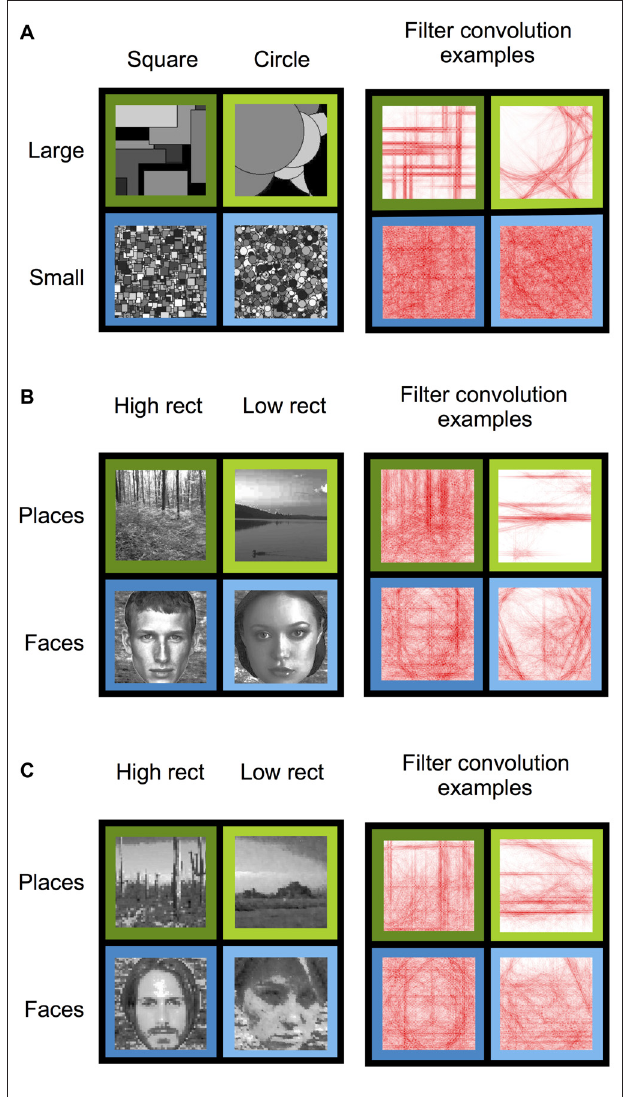
FIGURE 1 | Stimulus conditions (left) and example right angle convolution intensities (right) for Experiments 1–3. (A) Experiment 1 stimuli consisted of squares (high-rectilinearity) and circles (low-rectilinearity) that were either large or small in size. (B) Experiment 2 stimuli consisted of naturalistic high- and low- rectilinearity scene and face images. (C) Experiment 3 stimuli consisted of pixilated (high-rectilinearity) and pointillized (low-rectilinearity) scene and face images.